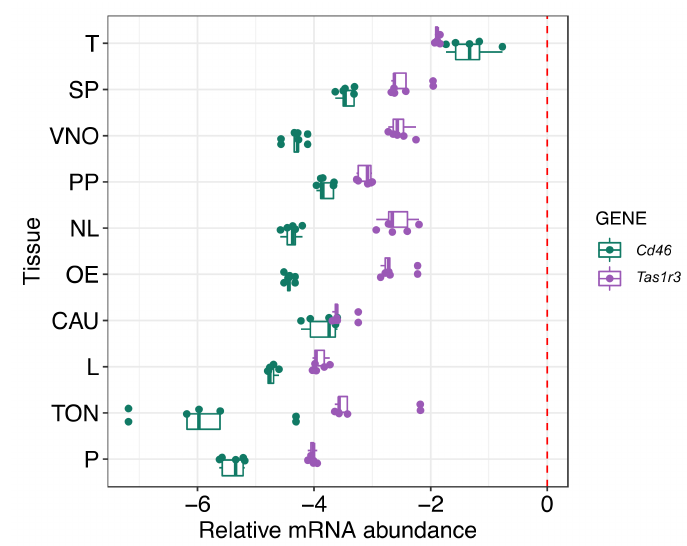
Figure 1. The expression of Tas1r3 and Cd46 is highest in testicles as revealed by qPCR analysis of mRNA across 10 mouse tissues. Prostate (P), tongue (TON), liver (L), cauda epididymis (CAU), olfactory epithelia (OE), lymph tissue (NL), nasal-associated major preputial gland (PP), Vomeronasal organ (VNO), spleen (SP) and testis (T). Normalized to Gapdh (dashed red line), n male =